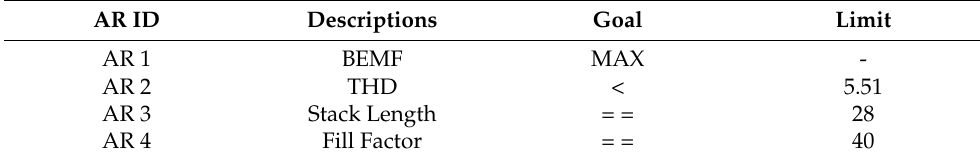
Table 3. Objectives and limitations of DRAFPM motor design variables.